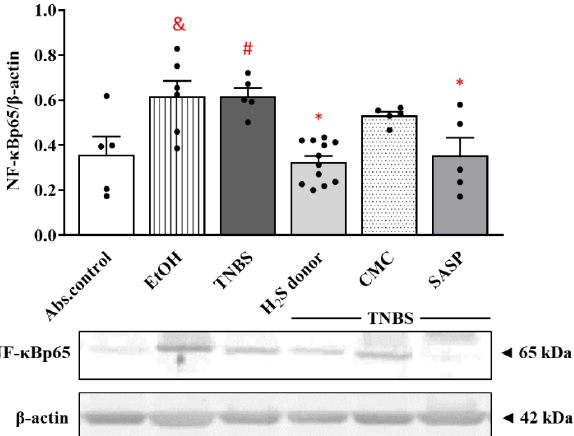
Figure 6. Changes in the expression of NF- κB p65 subunit following TNBS administration and treat- ment with H 2 S donor in the colon. Absolute control (no treatment); EtOH (50% ethanol, the solvent of TNBS); TNBS (2,4,6-trinitrobenzenesulfonic acid enema); H 2 S donor (TNBS + 18.75 µM/kg/day Lawesson’s reagent); CMC (TNBS + 0.5% carboxymethylcellulose, the vehicle of Lawesson’s rea- gent); SASP (TNBS + 50 mg/kg/day sulfasalazine, as a positive control). Results are presented as mean + S.E.M.; n = 5 – 12/group; one-way ANOVA, Holm – Sidak post hoc test, # p < 0.05 absolute control vs. TNBS; * p < 0.05 TNBS vs. TNBS + treatments; & p < 0.05 absolute control vs. EtOH.